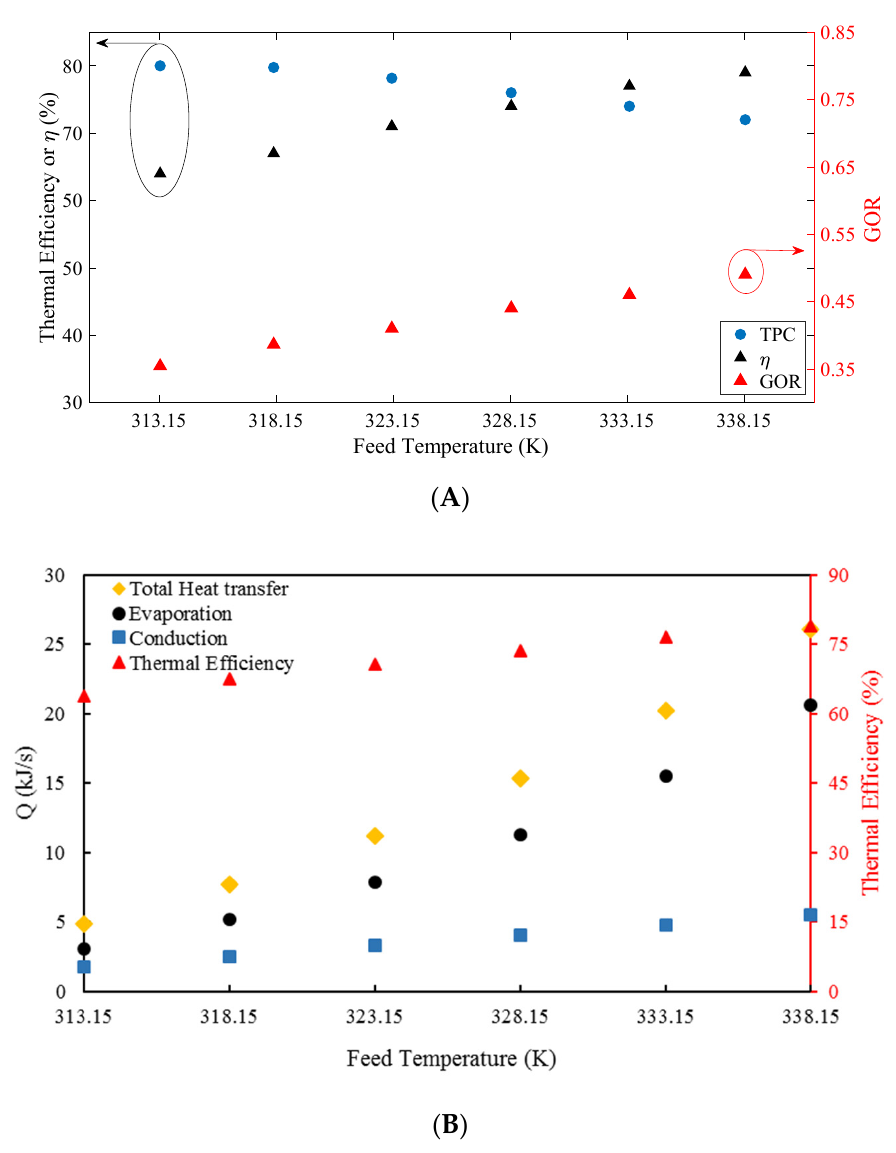
Figure 10. ( A ) The output efficiency parameters: thermal efficiency ( η ), gained output ratio (GOR), and temperature polarization coefficient (TPC) of the presented bispacer MDCMD as a function of feed temperature; ( B ) the evaporation, conduction, and total heat transfer and thermal efficiency of the bispacer multi-staged DCMD system.